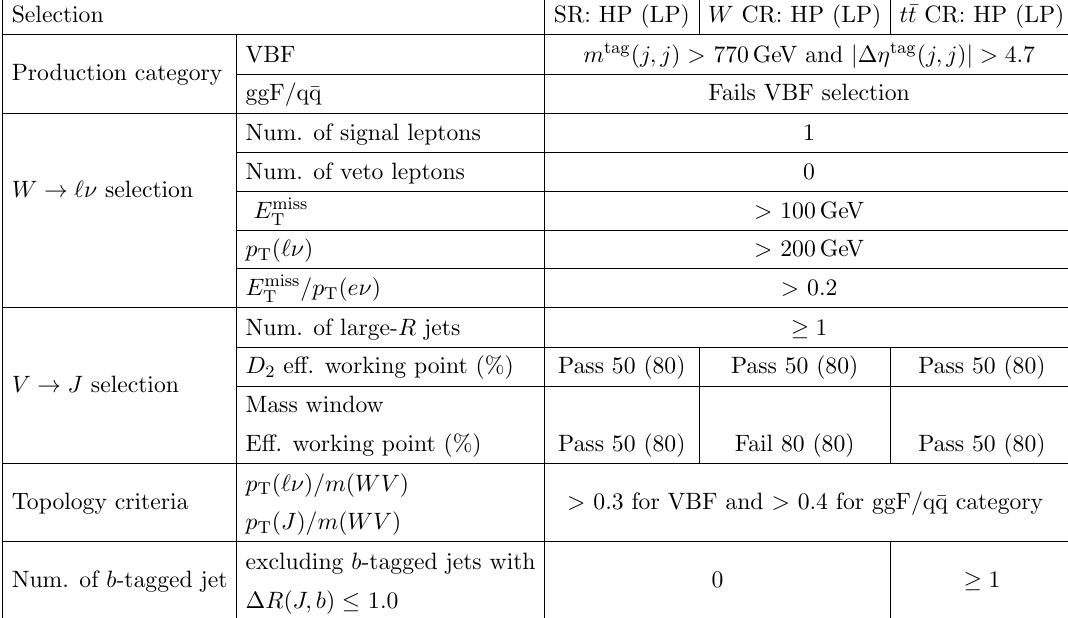
Table 1 . Summary of the selection criteria used to de(cid:12)ne the merged WW and WZ signal regions (SR) and their corresponding W +jets control regions ( W CR) and t (cid:22) t control regions ( t (cid:22) t CR) in the high-purity (HP) and low-purity (LP) categories. The events are also categorized according to their production mechanism, the VBF selection is prioritized and the remaining events are assigned to the ggF = q(cid:22)q